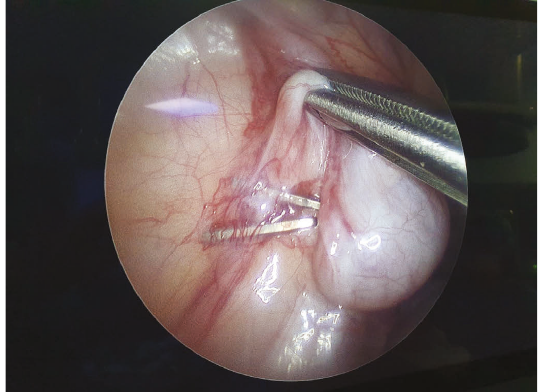
Figure 2: Laparoscopic image of Fowler–Stephens procedure for left intra-abdominal